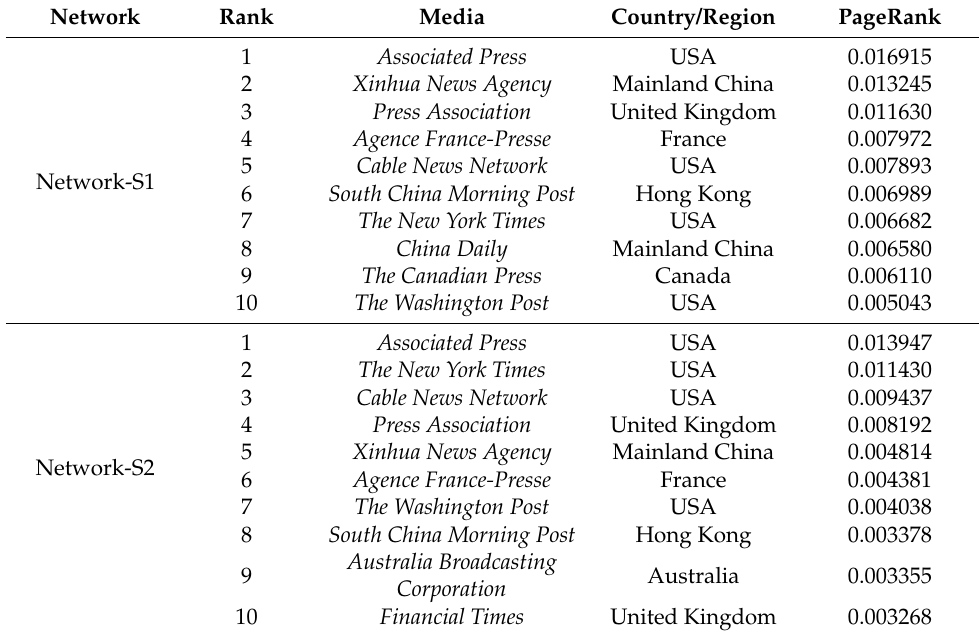
Table 4. Top 10 Media Outlets In Terms of